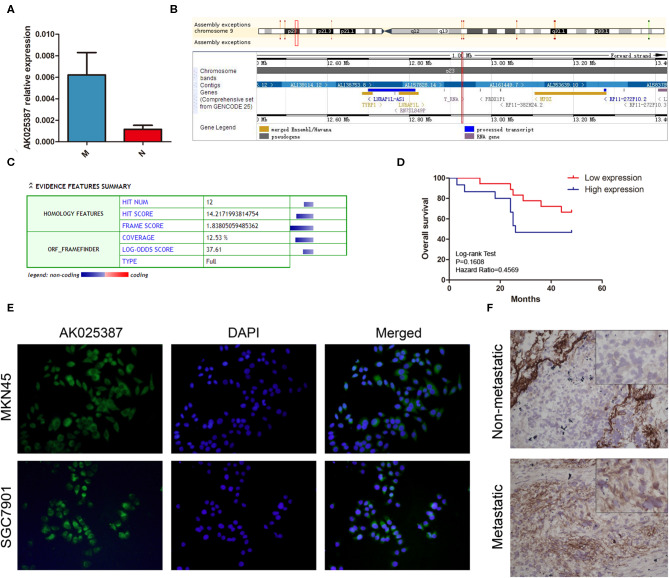
Expression of AK025387 in gastric cancer tissues and intracellular location of AK025387. (A) The relative expression of AK025387 was higher in the metastatic (M) group than that in the non-metastatic (N) group (P = 0.010). (B) Gene information of AK025387. AK025387 is transcribed on chromosome 9 p23, with a length of 1,892 nucleotides, containing two exons and one intron. (C) Coding Potential Calculator (CPC) results of AK025387 (coding potential score: 0.024, weak coding potential). (D) Correlation of AK025387 expression with survival of patients with gastric cancer. No significant correlation was observed between overall survival and AK025387 expression (P = 0.161). (E) Fluorescence in situ hybridization results of AK025387 in gastric cancer cell lines. AK025387 was located in both nucleus and cytoplasm, but mainly in cytoplasm in both MKN45 and SGC7901 cell lines. (F) The in situ hybridization results of AK025387 in metastatic and non-metastatic gastric cancer tissues (200×). AK025387 was located mainly in the cytoplasm.